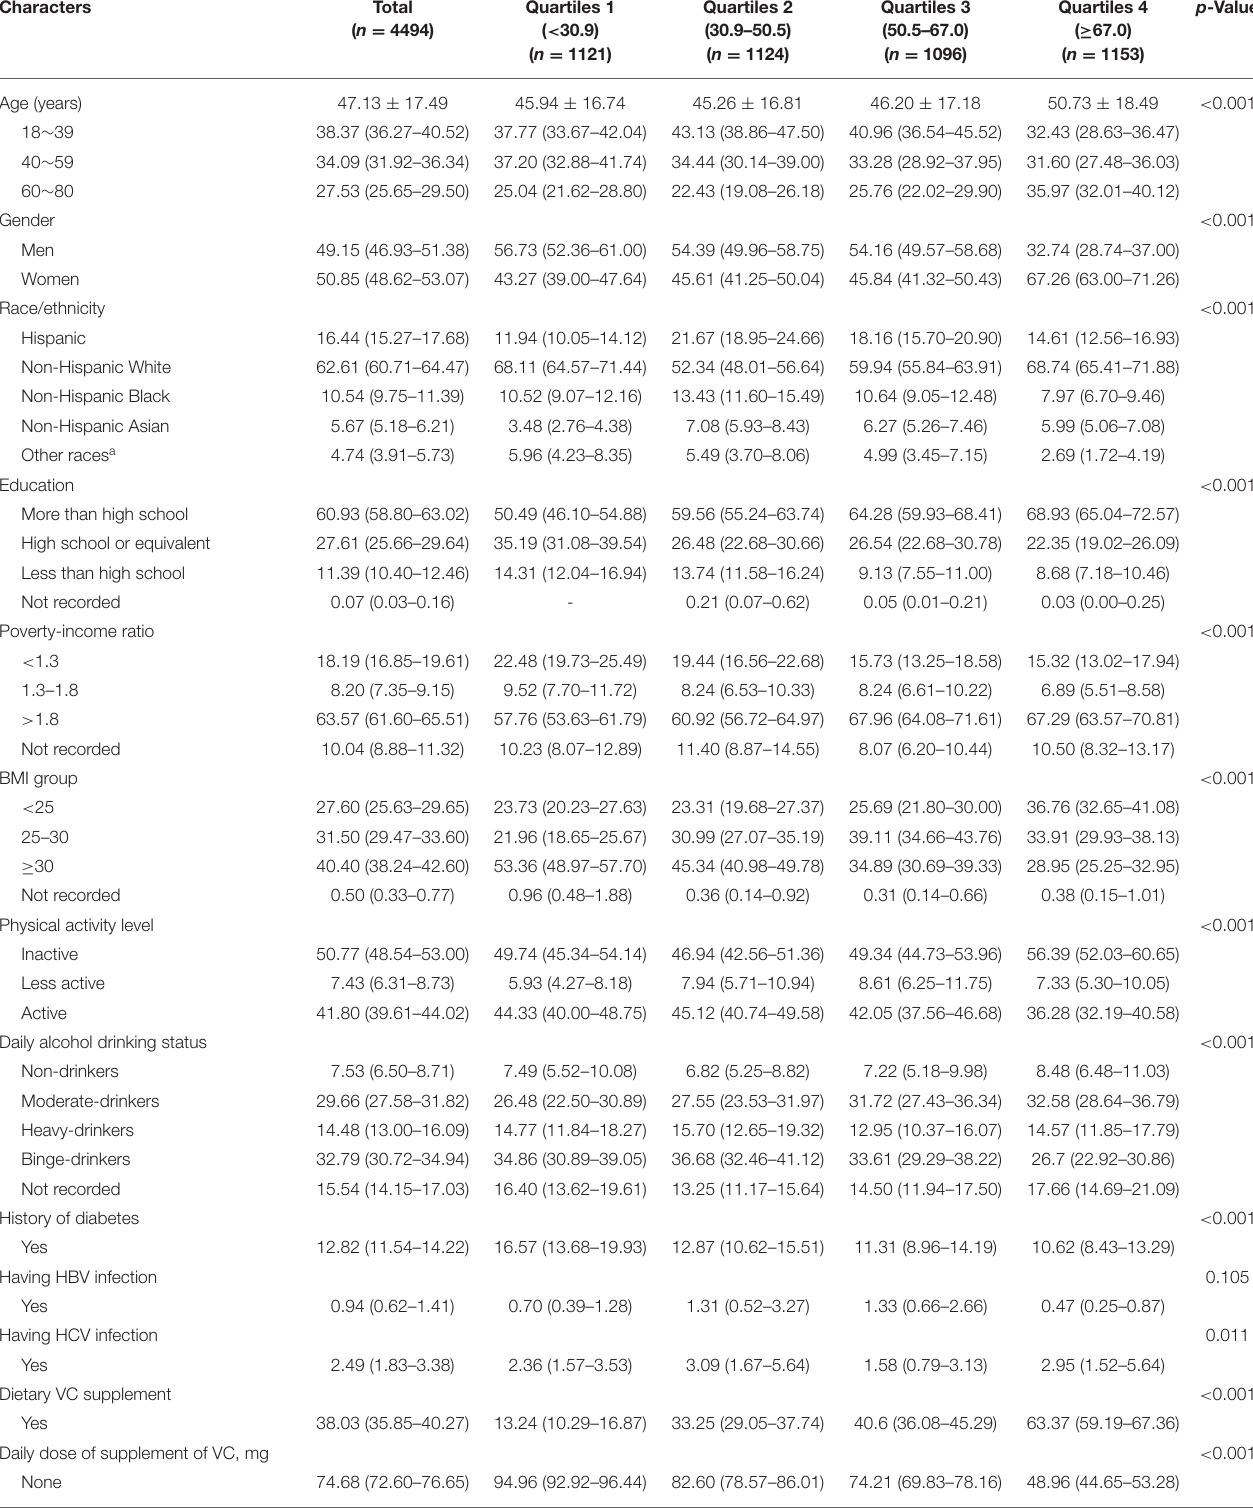
TABLE 1 | General characteristics of participants ( n = 4494) stratified by vitamin C (quartiles1-4, umol/L) in the NHANES